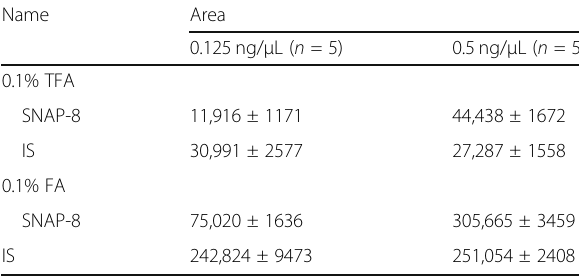
Table 1 Comparison of ionic strength between TFA and FA as additives in the mobile